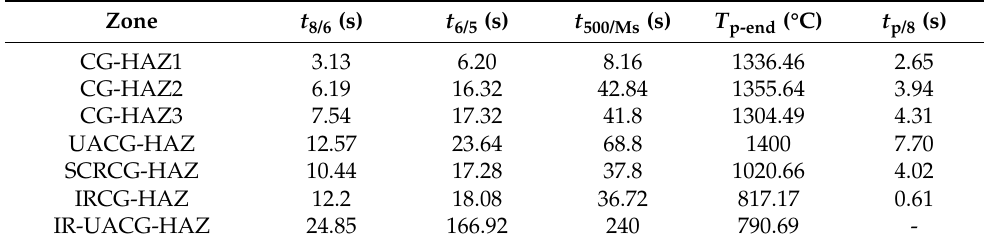
Figure 14. CCT curves of the base metal. Table 10. Cooling time of typical temperature ranges in the thermal simulation